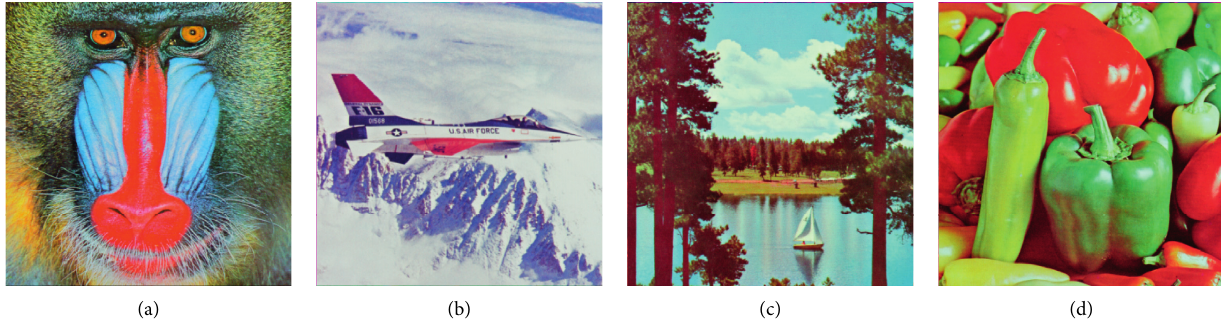
Figure 3: Sub-dataset used as input images (sourced from [32]) to validate the proposed cryptosystem. (a) Ig01. (b) Ig02. (c) Ig03. (d) Ig04.